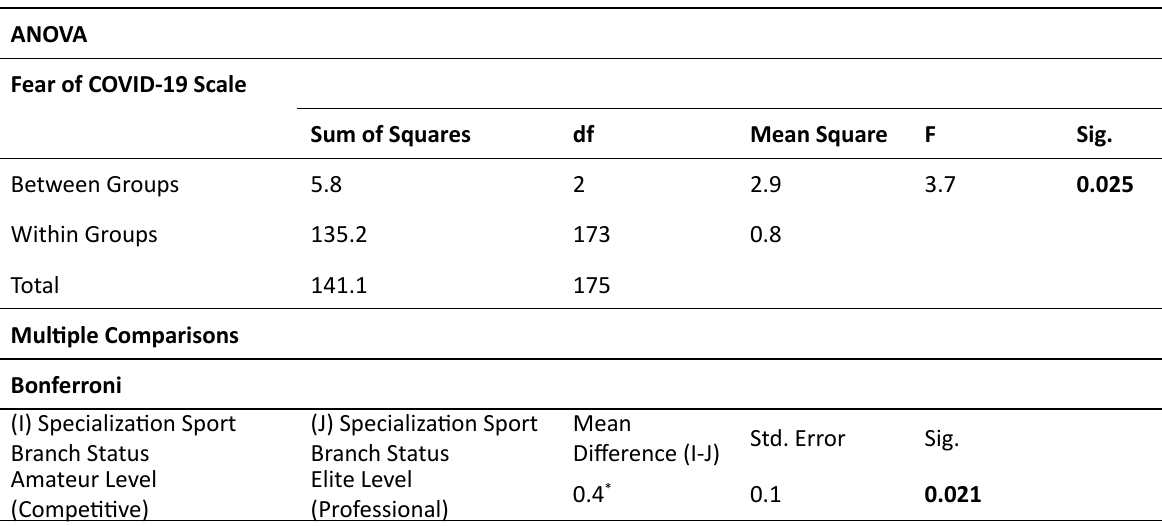
Table 5. One-Way ANOVA and Multiple Comparison Test (Bonferroni) Results According to the Variable of Specialization Sports Branch Level